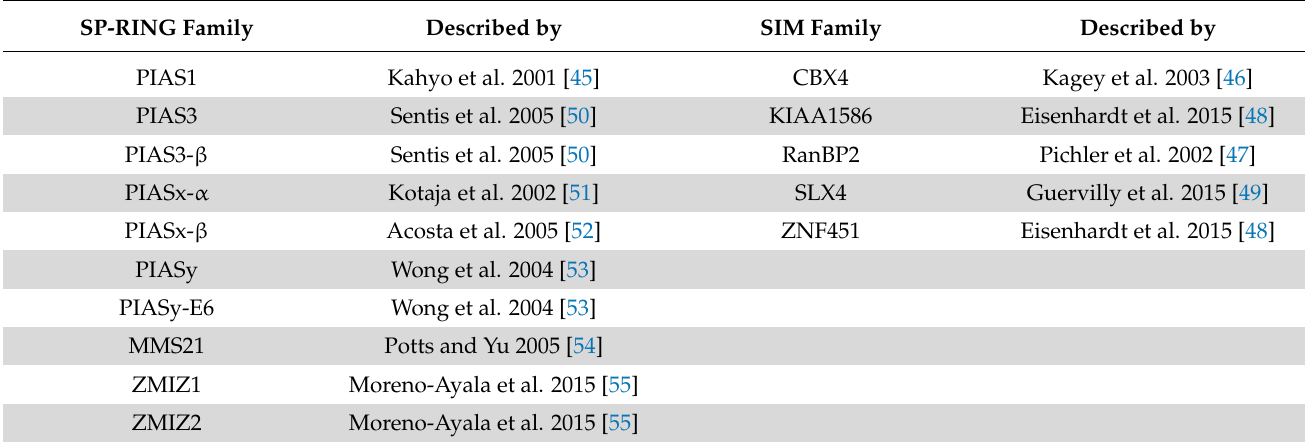
Table 1. Categorization of SUMO E3